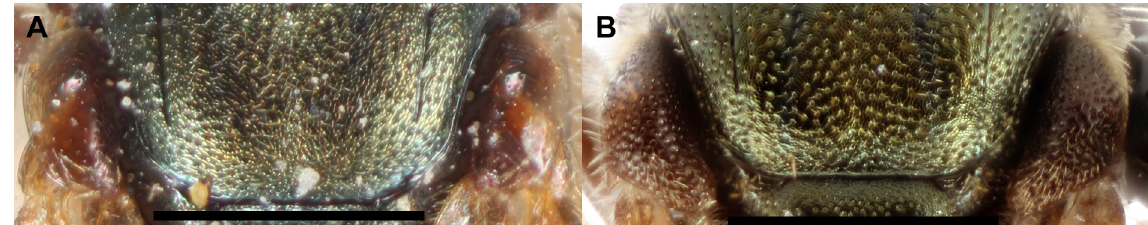
Fig. 79. Tegulae. A . Lasioglossum perparvum (Ellis, 1914), ♀, sparsely punctate, not exceeding posterior margin of mesoscutum, and inner posterior margin straight. B . L. magnitegula sp. nov., ♀, densely punctate, exceeding posterior margin of mesoscutum, and inner posterior margin concave. Scale bars = 0.5 mm.